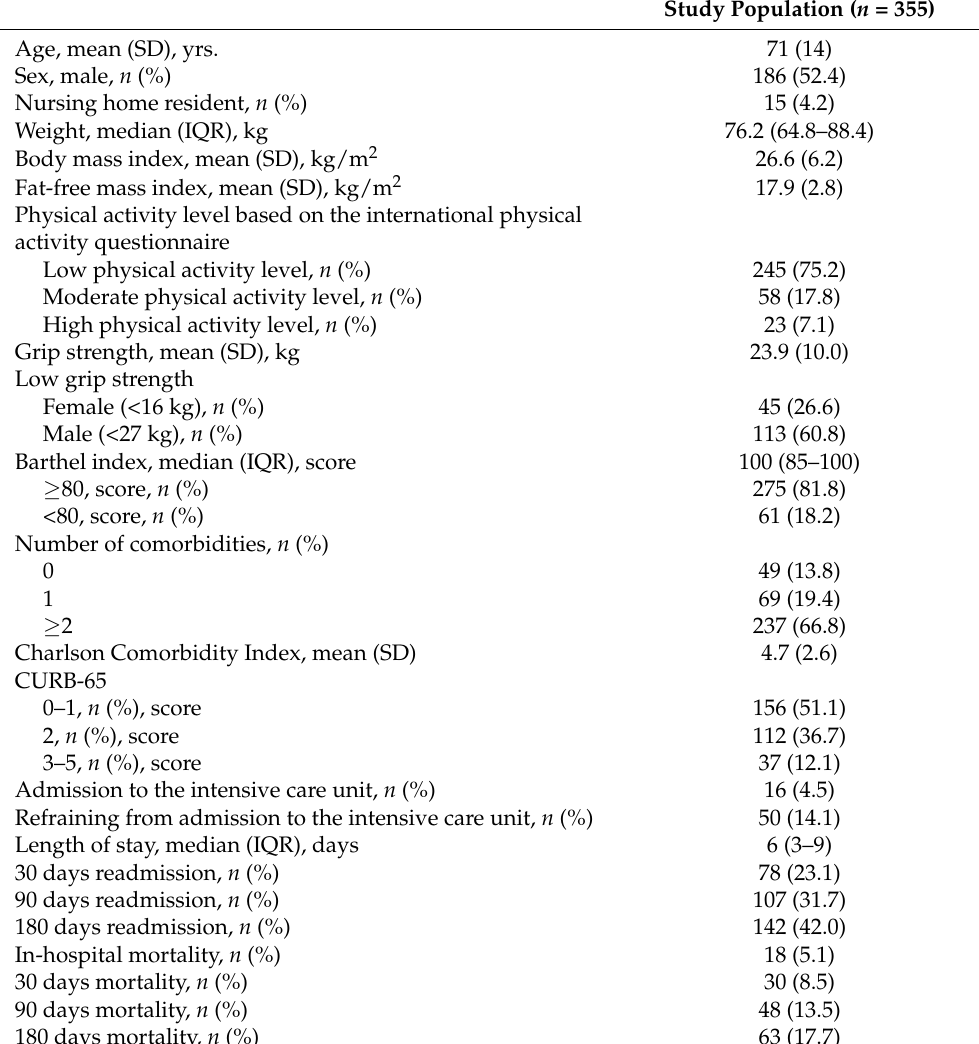
Table 1. Baseline characteristics of 355 patients hospitalized with community-acquired